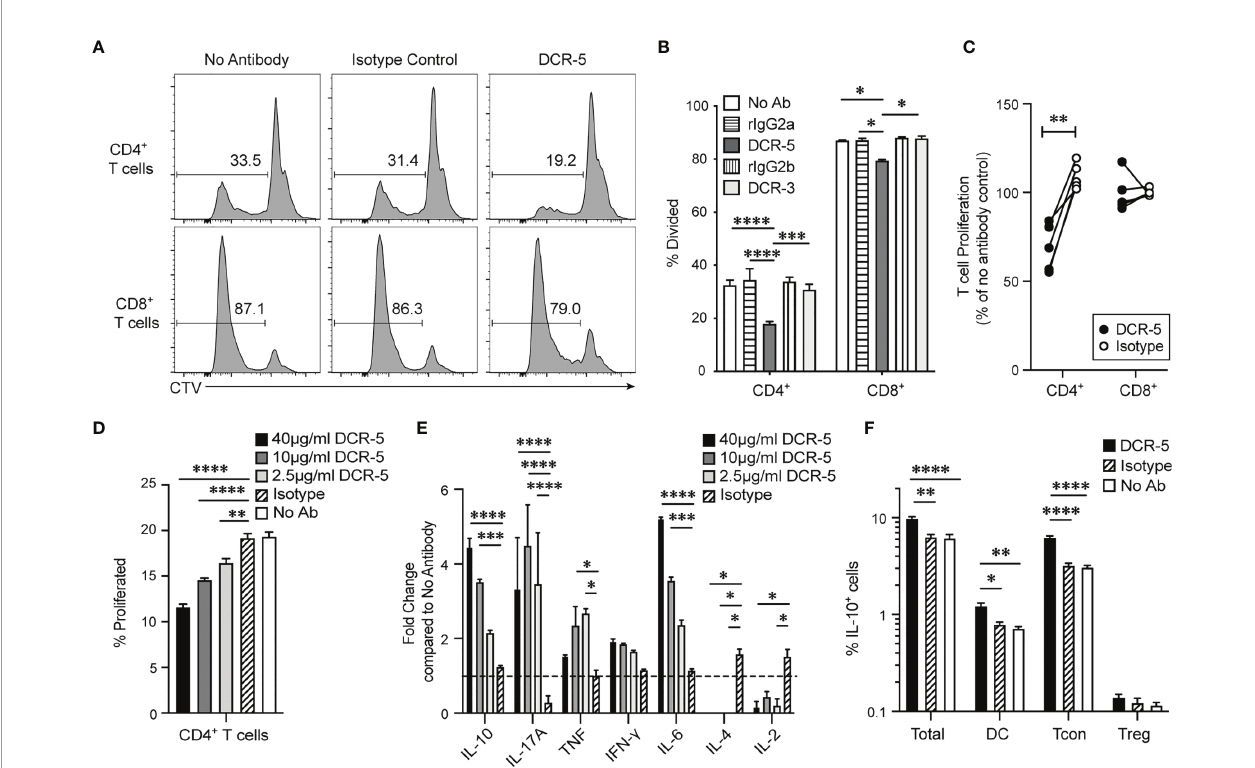
FIGURE 3 | DCR-5 prevents T cell proliferation in vitro . BALB/c and CTV-labeled B6 splenocytes were cocultured for 84 h in MLR at a 1:1 ratio with 20 µg/ml DCR-5, DCR-3, isotype controls or no antibody. Proliferation of gated CD3 + CD4 + or CD8 + B6 T cells was determined by CTV dilution. (A) Representative histograms showing % divided CD4 + and CD8 + T cells in indicated groups. (B) Mean levels of division in triplicate wells. Statistical comparison was determined using 2-way ANOVA. (C) Summary of fi ve MLR experiments where T cell proliferation is represented as % of no antibody control. Statistical comparison was determined using a paired T-test. (D) CD4 + T cell proliferation and (E) cytokines in supernatant of B6 × BALB/c MLR treated with the indicated DCR-5 concentrations or 40 µg/ml isotype control after 84 h (n = 3). Cytokine data is shown as fold change compared to mean of no antibody control (dashed line). (F) Percentage of total cells, CD3 + CD4 + FoxP3 − (Tcon) CD3 + CD4 + FoxP3 + (Treg) T cells and CD11c + IAIE + (DC) that stained IL-10 + by intracellular fl ow cytometry staining after 48 h culture of B6 × BALB/c MLR with 20 µg/ ml DCR-5, isotype control or no antibody. Statistical comparison to isotype control was assessed by one-way ANOVA. *p < 0.05, **p < 0.01, ***p < 0.001 and ****p <